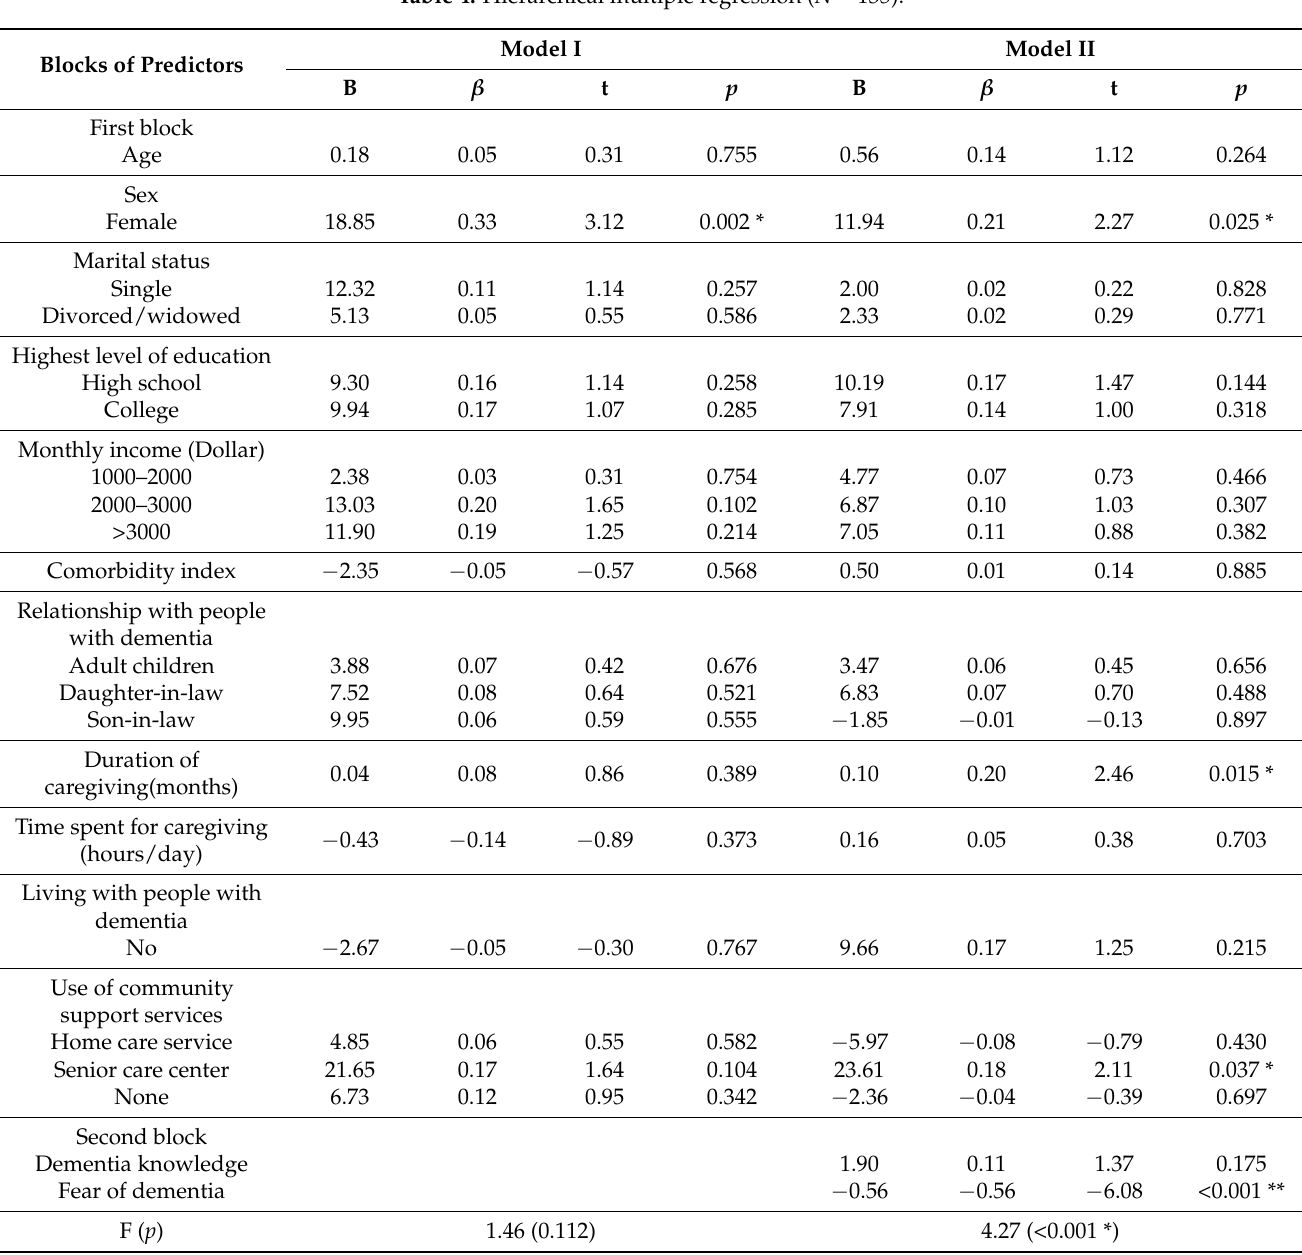
Table 4. Hierarchical multiple regression ( N =